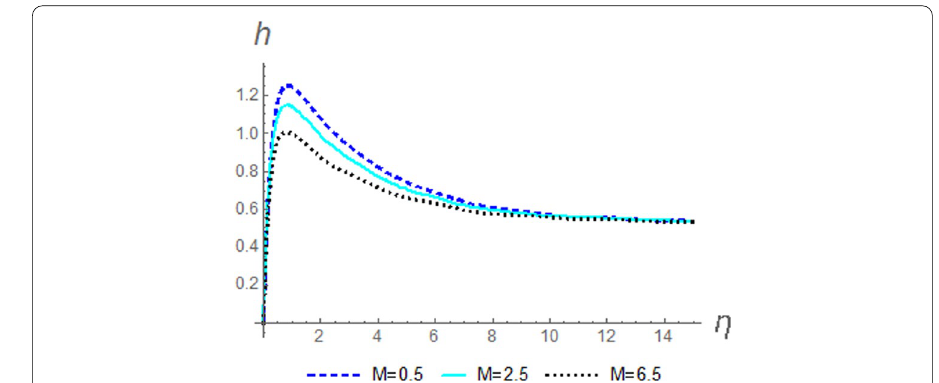
Fig. 5 Effect of M on the velocity profile